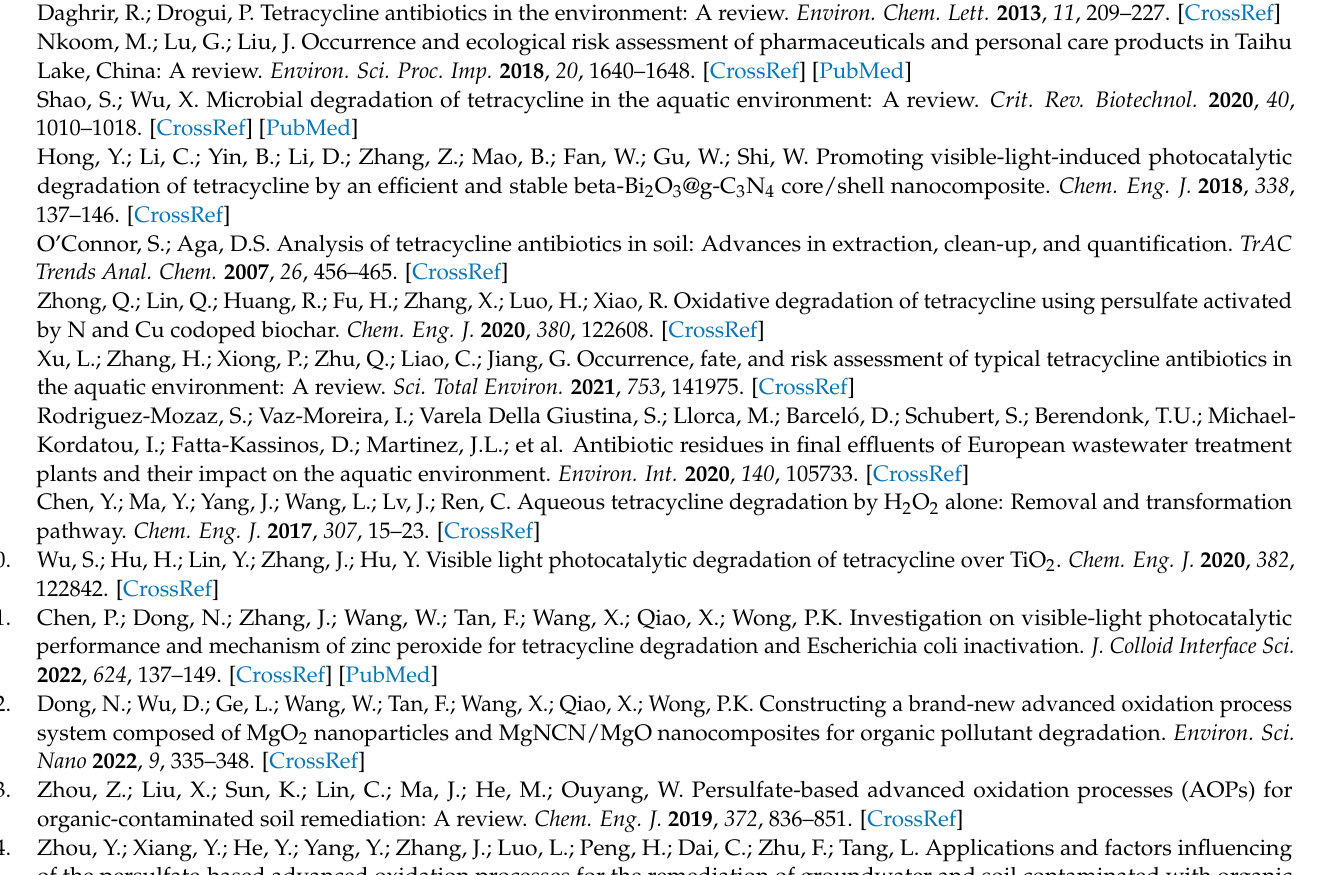
species; Figure S7: XRD pattern (a), Raman spectrum (b) and O 1s spectrum (c) of used CNT-O-H; Figure S8: Impedances of raw CNTs, CNT-O and